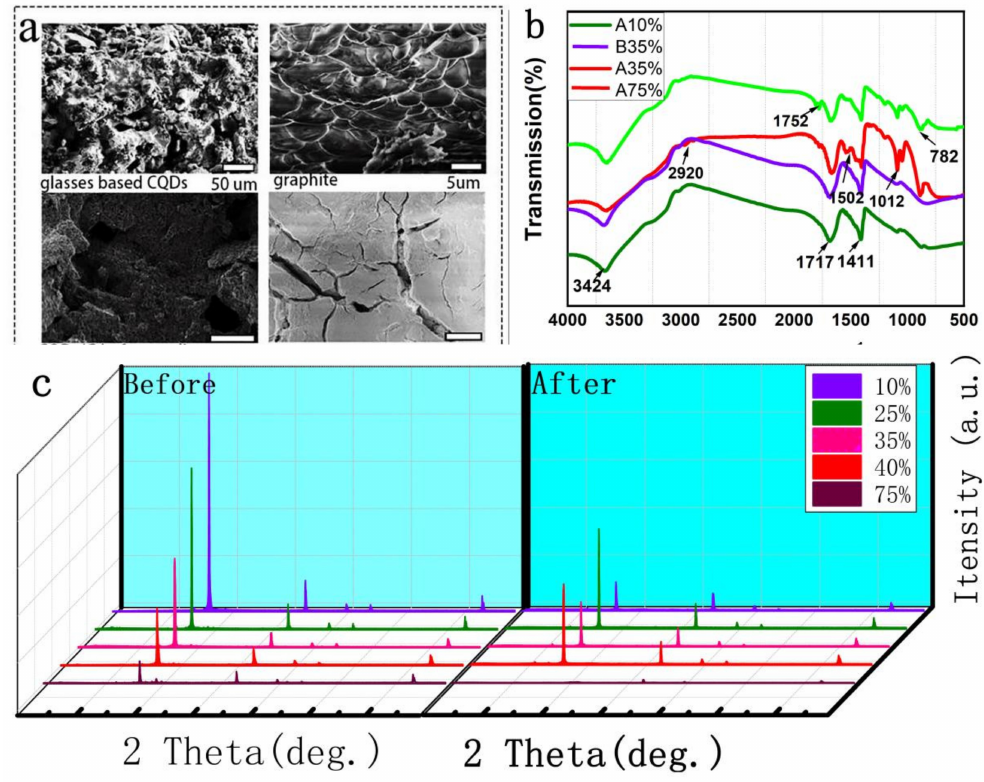
Figure 4. Character measurements of CQDs/G. The SEM of 35% CQDs/G before and after cycling under 100, 20 um ( a ), IR of 10%, 35%, 75% CQDs/G after cycling and 35% CQDs/G before cycling ( b ), XRD patterns of 10%, 25%, 35%, 40%, 75% CQDs/G before and after the cycles; Li3Pb corresponds to PDF # 00-008-0207, LiGe corresponds to PDF# 97-006-0843, CsBr corresponds to PDF # and Cs 4 PbBr 6 corresponds to PDF# 97-002-5124 GeO 2 corresponds to PDF# 97-063-7456, Cu corresponds to PDF# 97-004-3493 ( c ).